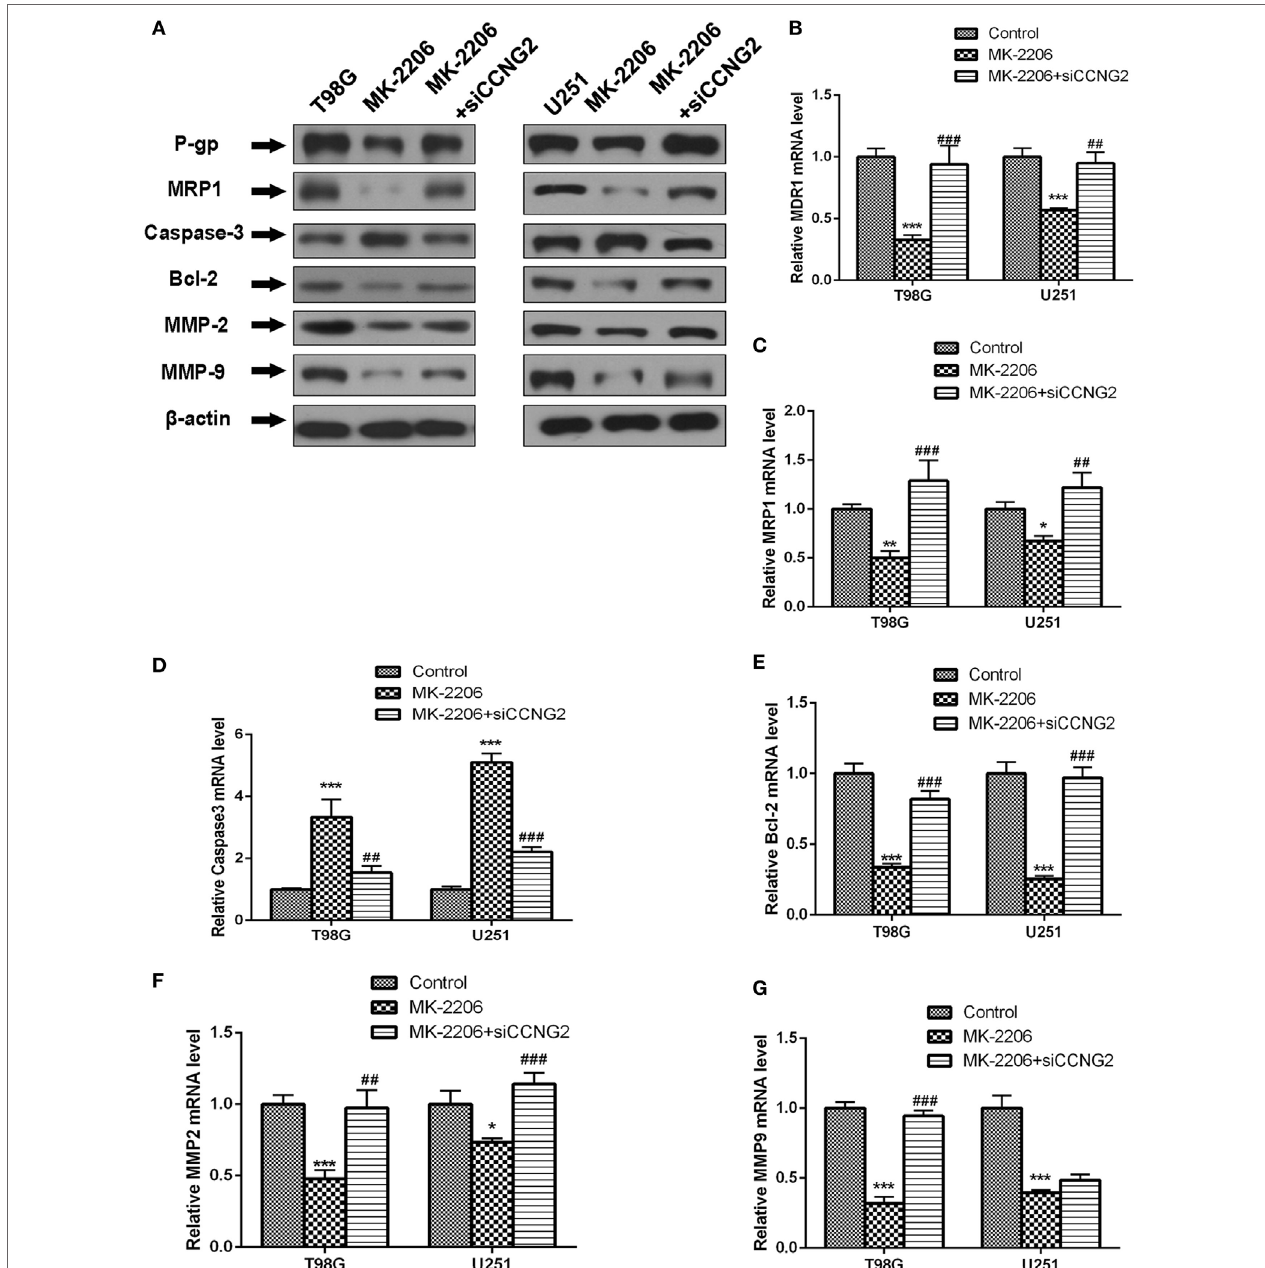
FigUre 6 | Effect of inhibited AKT on protein and mRNA expression of MDR1 (P-gp), MRP1, Bcl-2, caspase-3, MMP-2, and MMP-9 in T98G and U251 cells. (a–g) Western blot and RT-PCR analysis of protein and mRNA levels of MDR1 (P-gp), MRP1, caspase-3, Bcl-2, MMP-2, and MMP-9 in T98G and U251 cells treated with MK-2206 or siCCNG2 or vehicle control. Data were expressed as mean ± SEM ( n = 3). ** P < 0.01 and *** P < 0.001, # P < 0.05, ## P < 0.01, ### P <